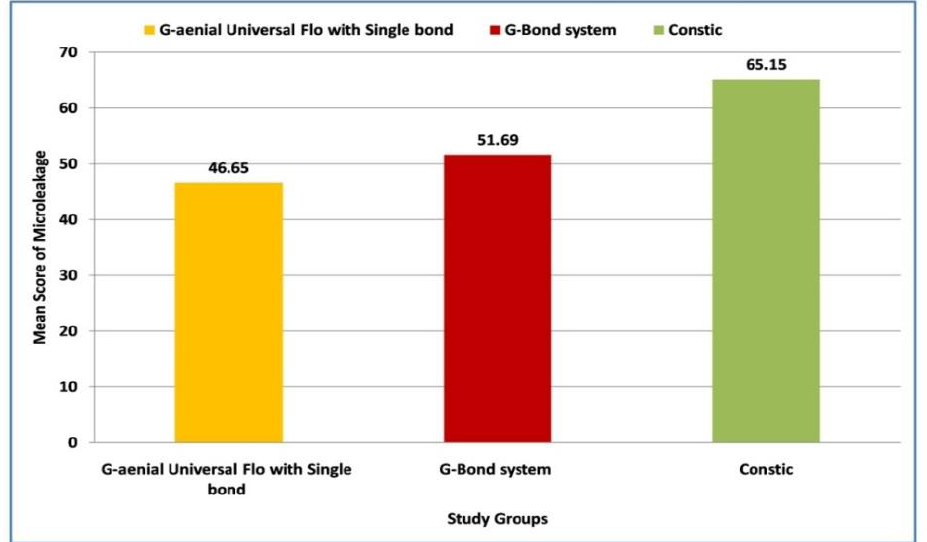
Figure 1. Comparison of mean values of microleakage in class V cavities with Single Bond and G-Bond system and Constic, using G-aenial Universal Flo.